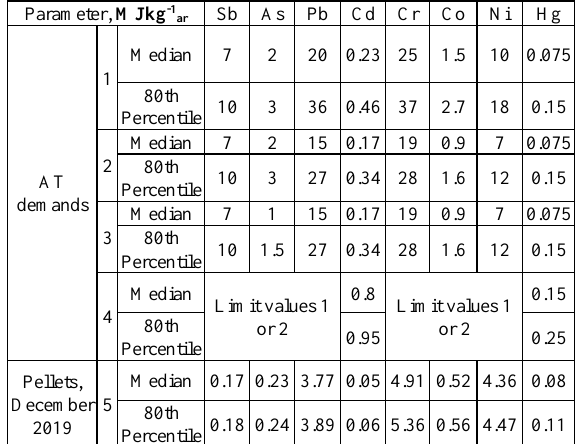
Austrian law [30]